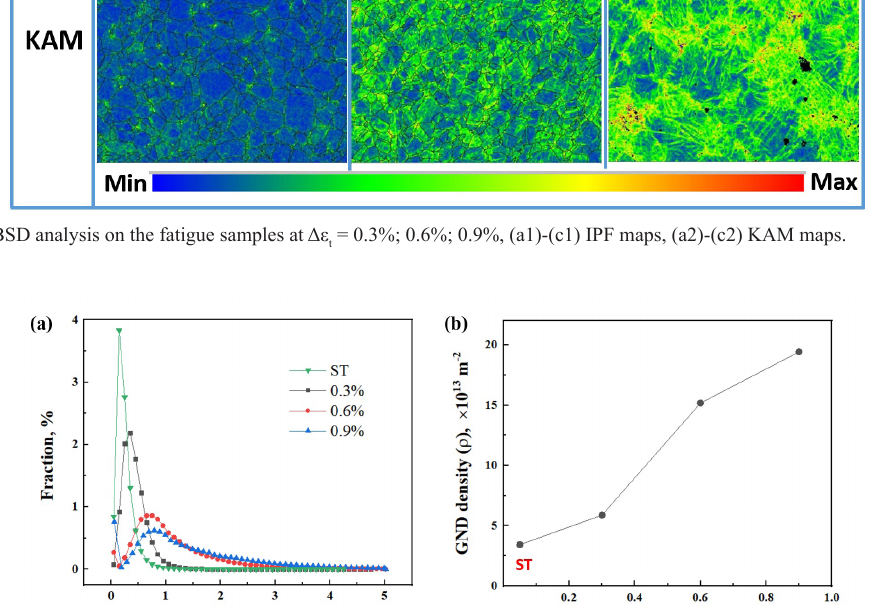
Figure 4. (a) Distribution of KAM value in fatigued samples determined by EBSD analysis from Figure 3 ; (b) GND density with different strain